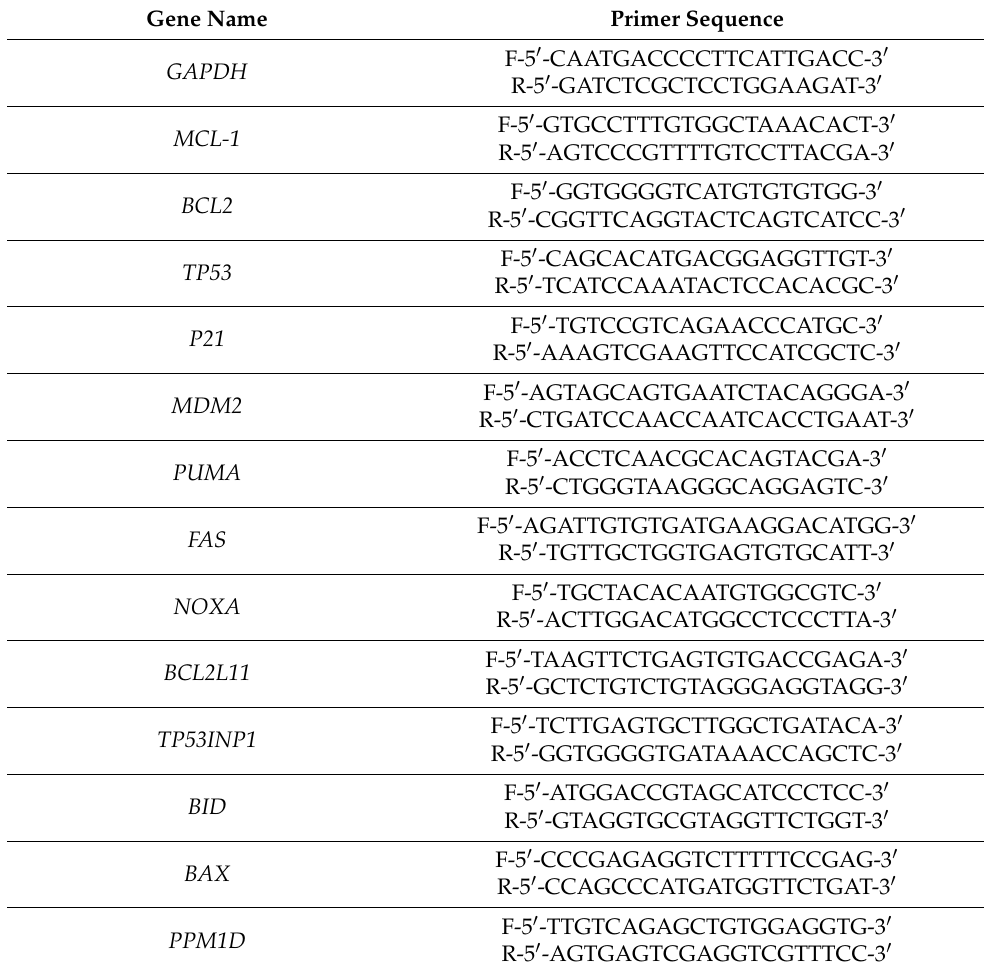
Table A2. Details of primers used for